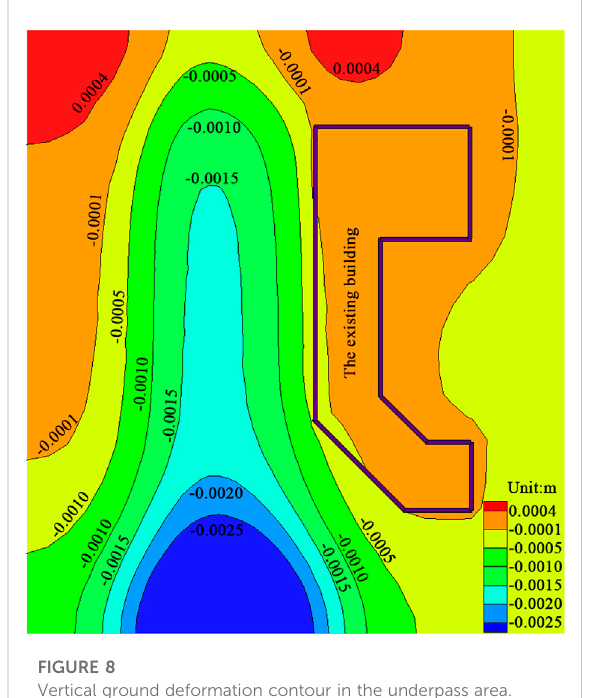
FIGURE 8 Vertical ground deformation contour in the underpass area.